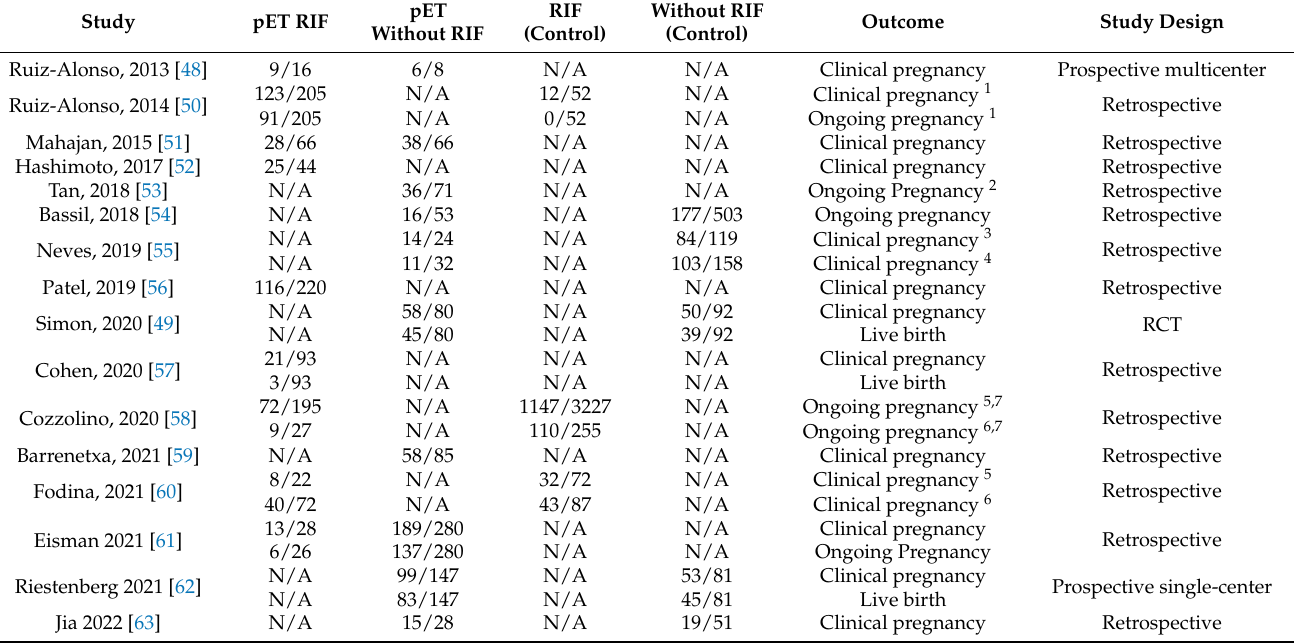
Table 1. Summary of evidence regarding the efficiency of the ERA